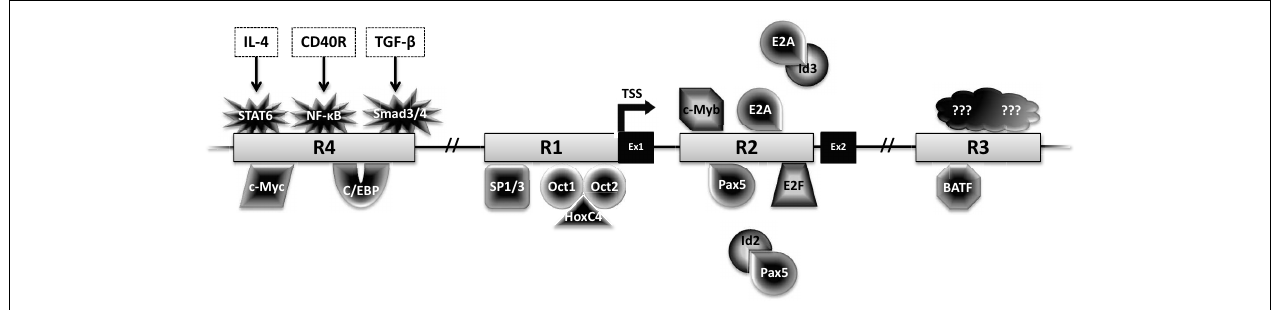
FIGURE 3 |Transcriptional regulation ofAID .The Aicda locus contains four conserved regulatory regions (R1–4).The first two exons (Ex1–2) and transcription factors with the potential to bind these regions are shown. Factors with black center and white text are activators, while factors with white center and black text are